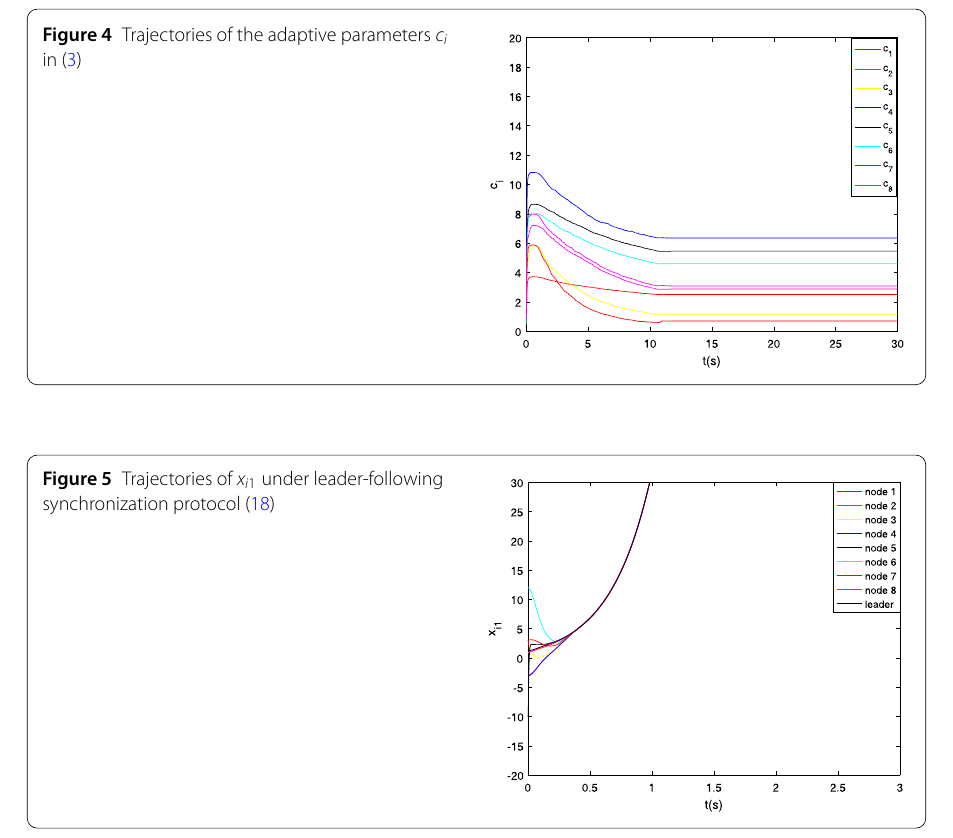
Figure 4 Trajectories of the adaptive parameters c i in (3)